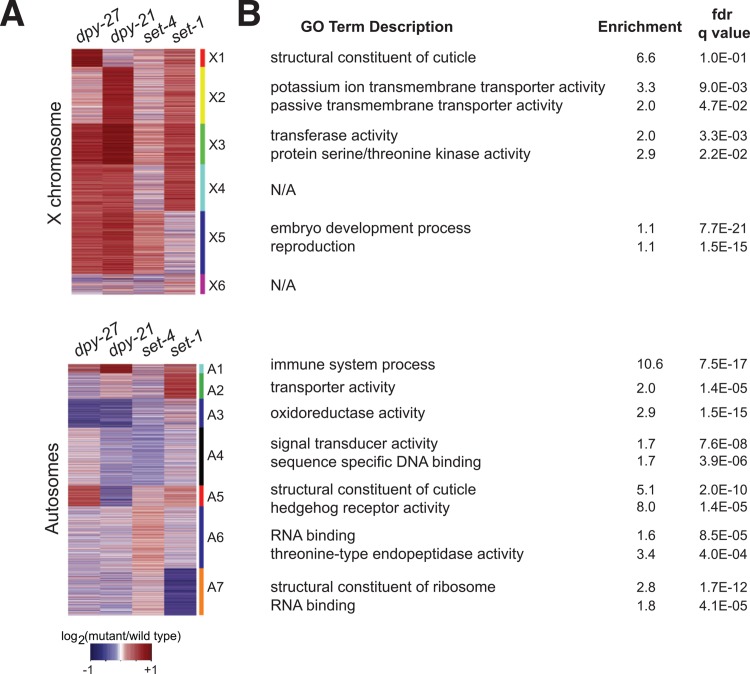
Gene regulation by dpy-27, dpy-21, set-4 and set-1 across the X chromosome and autosomes.(A) K-means clustering was performed using log2 ratios of expression in dpy-27/control RNAi, dpy-21(e428)/N2, set-4(n4600)/N2, set-1(tm1821) homozygous/heterozygous L3 worms. The clusters are indicated with a color and number to the right of the heat map. (B) GO term analyses indicate the enrichment of gene functions for each cluster compared to the rest of the X or autosomes. Additional GO terms are provided in S4 File.